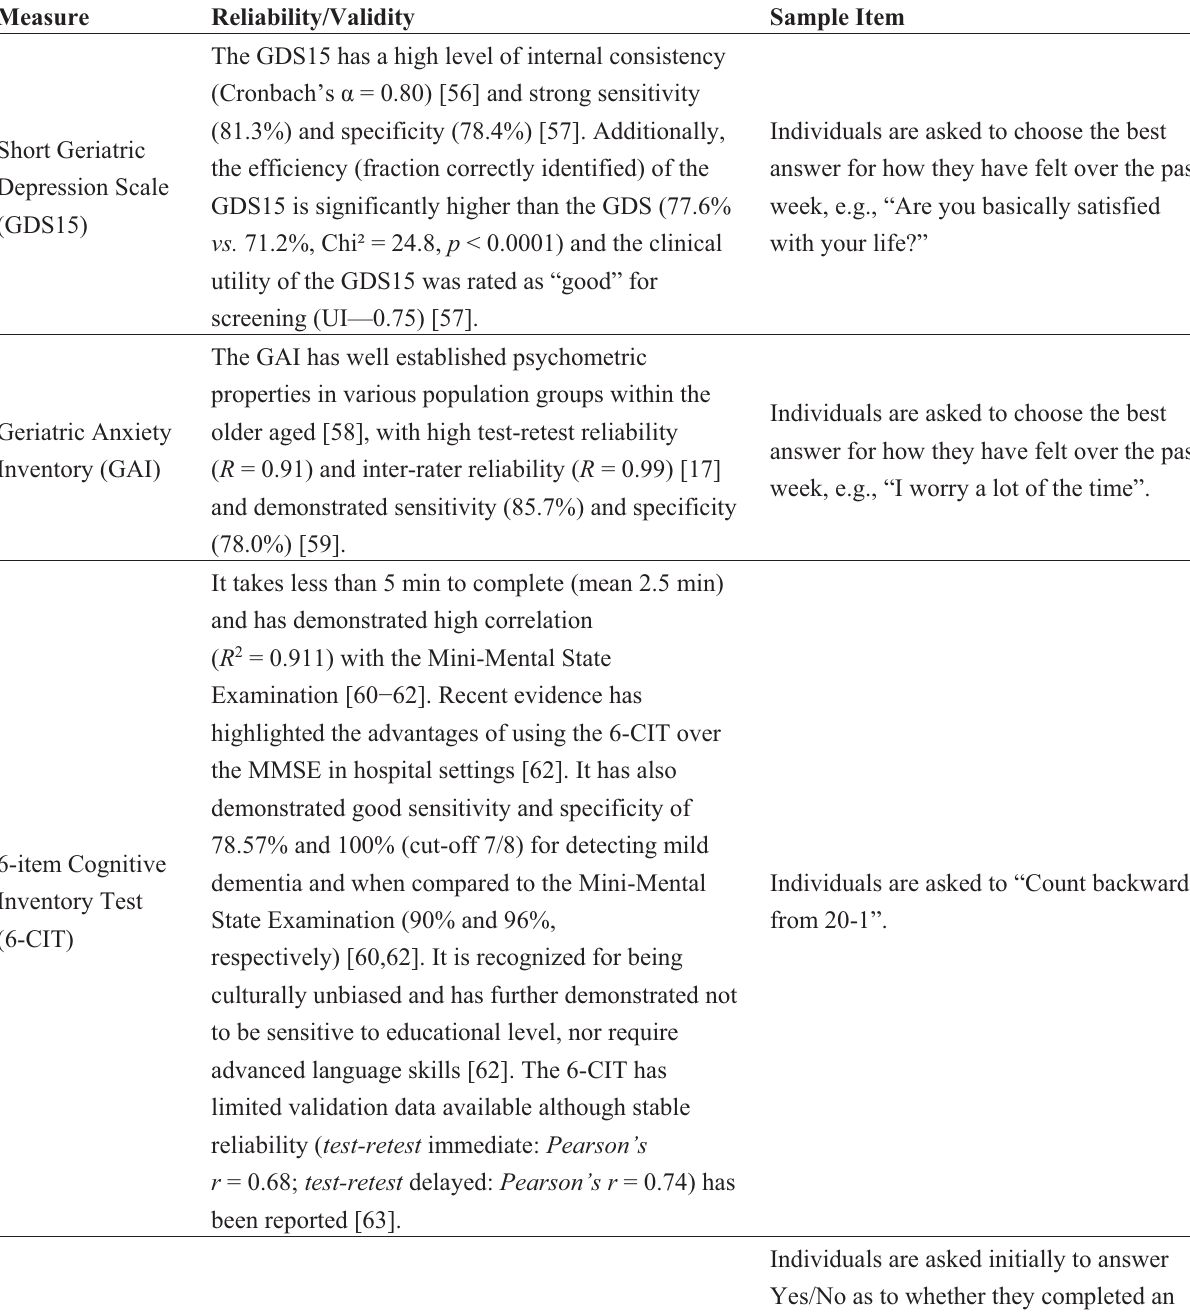
Table A1. Psychometric properties of proposed tools to be